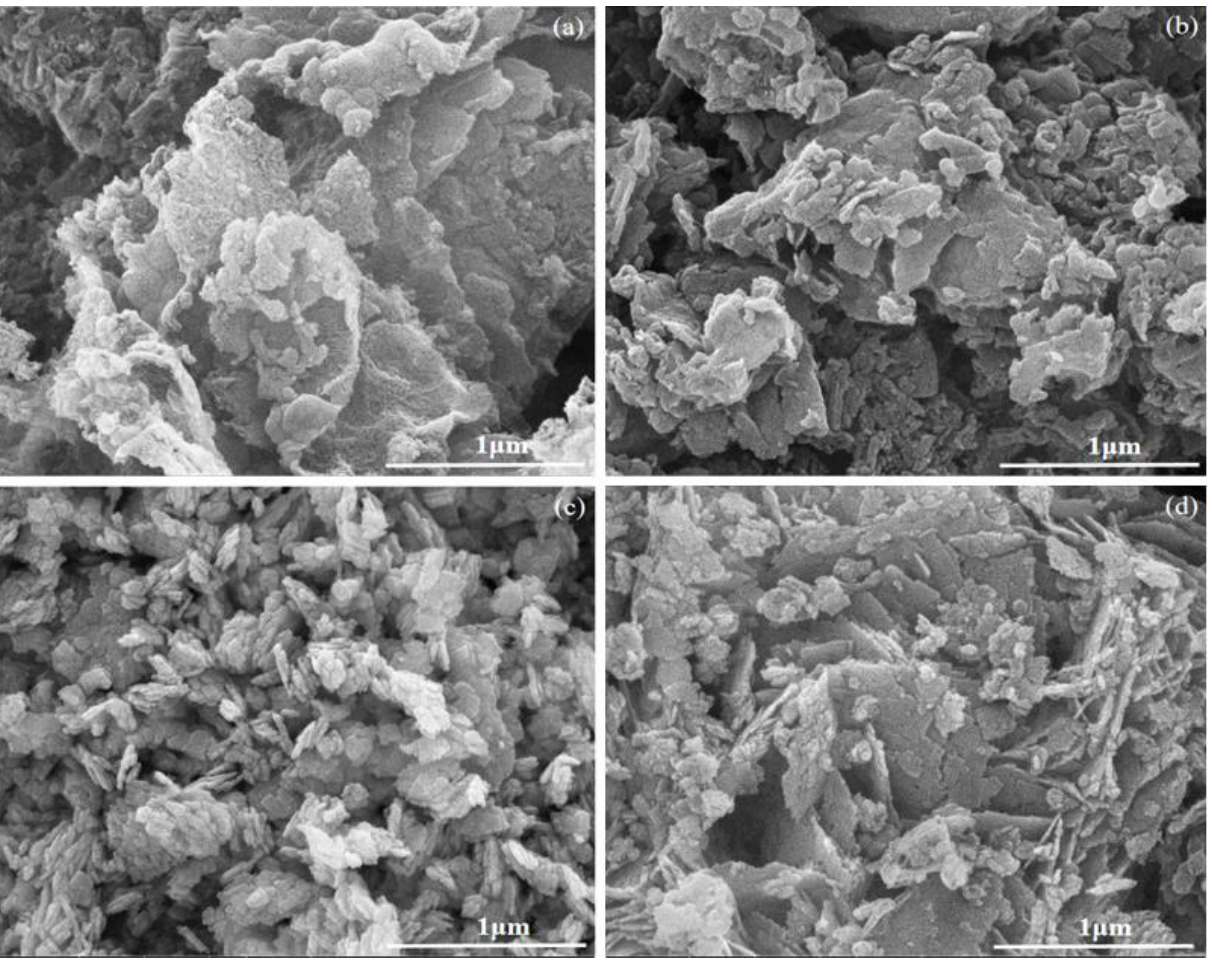
Figure 4. SEM images of ( a ) CNS, ( b ) PCNS, ( c ) BWO, and ( d ) 30% PCNS/BWO. The BET specific surface areas of the samples were calculated from the N 2 adsorp- tion/desorption isotherms shown in Figure 6. All of the samples had type IV isotherms with H3 type hysteresis, and the pore sizes were all less than 20 nm, indicating that the cat- alyst surfaces had mesoporous structures [41]. The specific surface areas of the CNS, PCNS, BWO, and 30% PCNS/BWO samples were 29.5653, 15.9839, 17.9569, and 47.1471 m 2